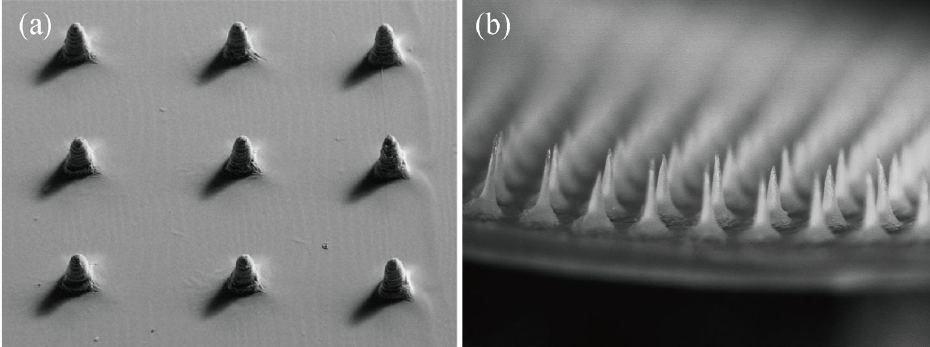
Figure 5. Morphologies of microneedles prepared by different methods: ( a ) 3D printing; ( b ) Formwork pouring method. Image used with permission of [30,88].